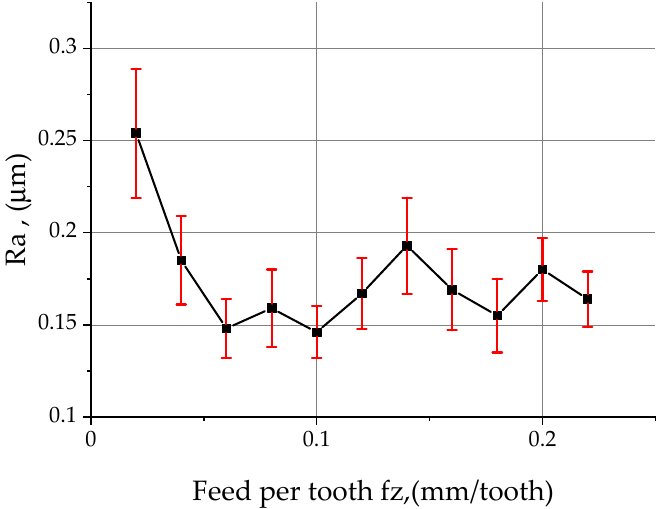
Figure 10. Effect of feed rate on the Ra parameter of surface roughness during face milling of samples made of 2017A alloy.